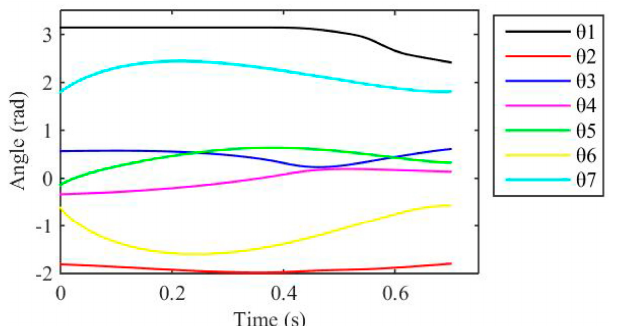
Figure 8. Joint angles of the biped robot during simulated walking. These angles have the same definitions as those in Figure 2.